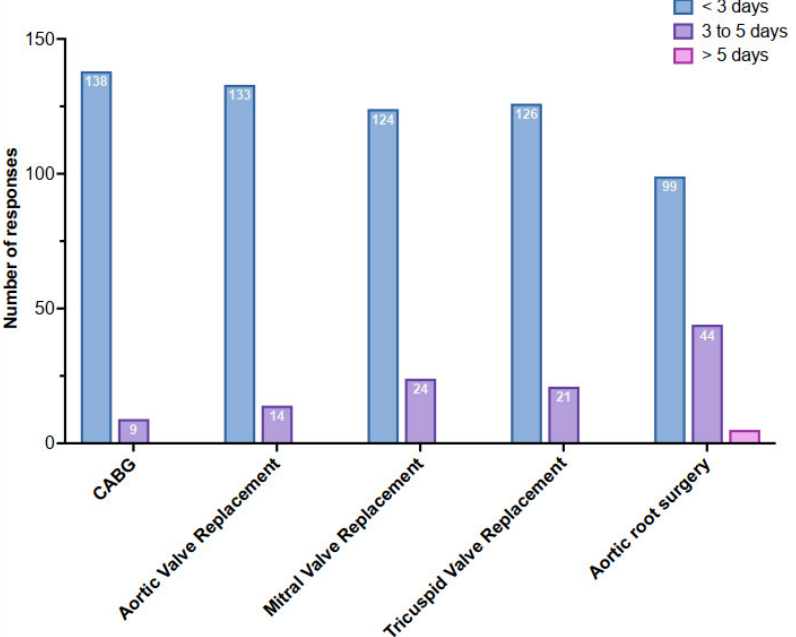
Figure 3. Collected responses regarding the timing of chest/pericardial drain removal according to cardiac surgery procedure.